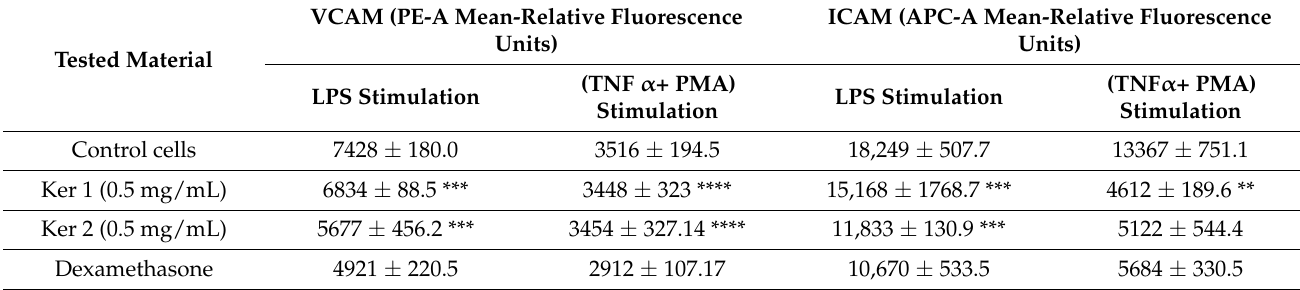
Table 8. Adhesion molecules’ modulation by keratin hydrolysates in activated vascular endothelial cells (HUVEC).